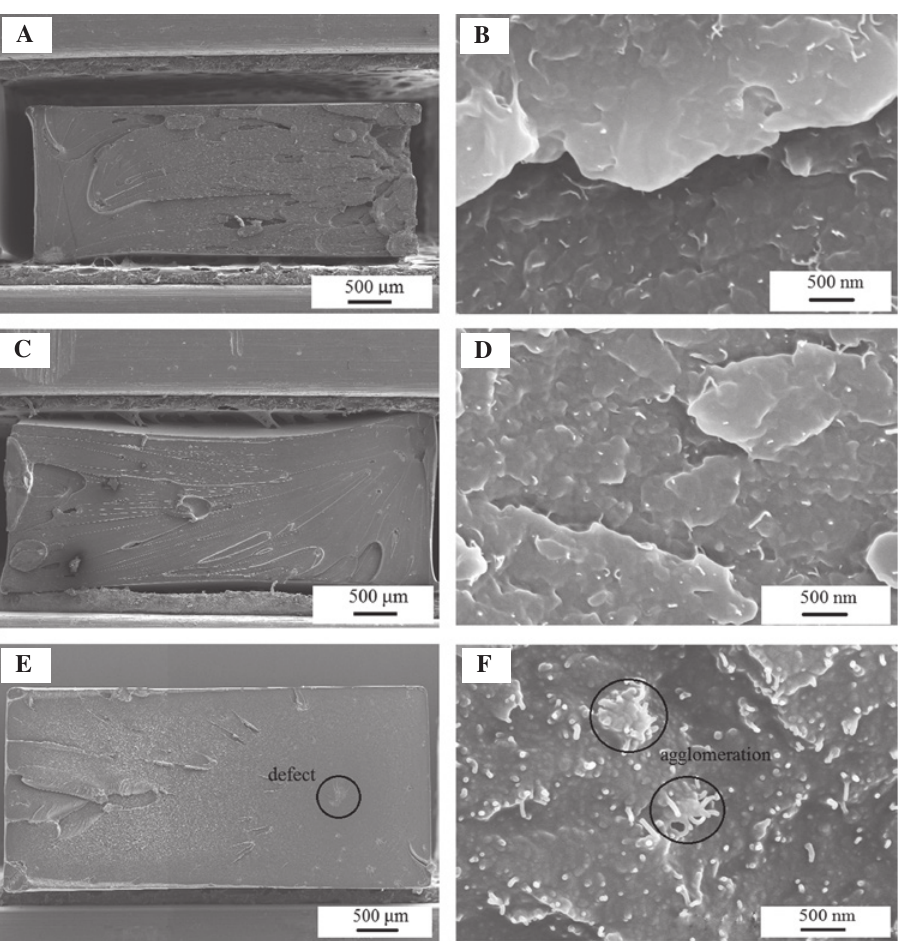
Figure 3: SEM micrographs of the fractured surfaces of (A) 1 wt.% MWCNT/PC composites obtained at the injection temperature of 330 ° C and injection speed of 10 mm/s, (C) 1 wt.% MWCNT/PC composites obtained at the injection temperature of 280 ° C and injection speed of 10 mm/s, (E) 5 wt.% MWCNT/PC composites obtained at the injection temperature of 280 ° C and injection speed of 10 mm/s. (B, D, and F) Large magnification micrographs of A, C, and E,